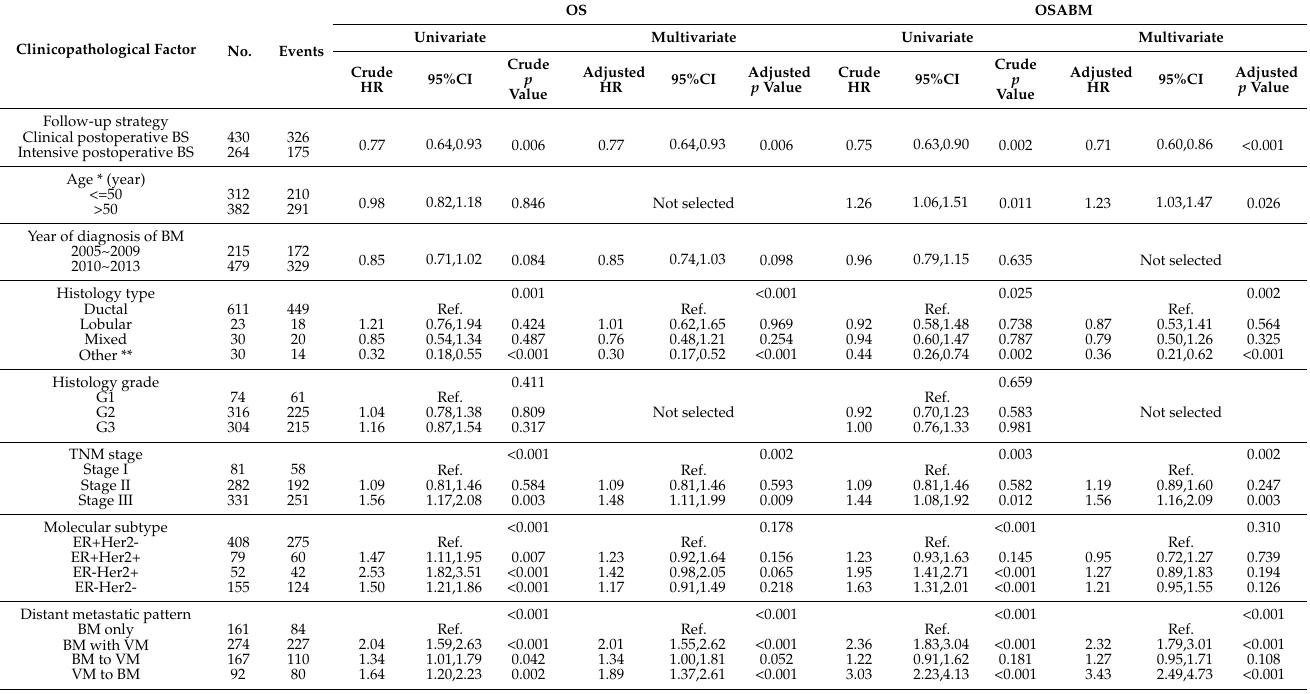
Table 2. Univariate and multivariate analysis of clinicopathological factors affecting OS and OSABM among eligible patients (N = 694) after PSM.